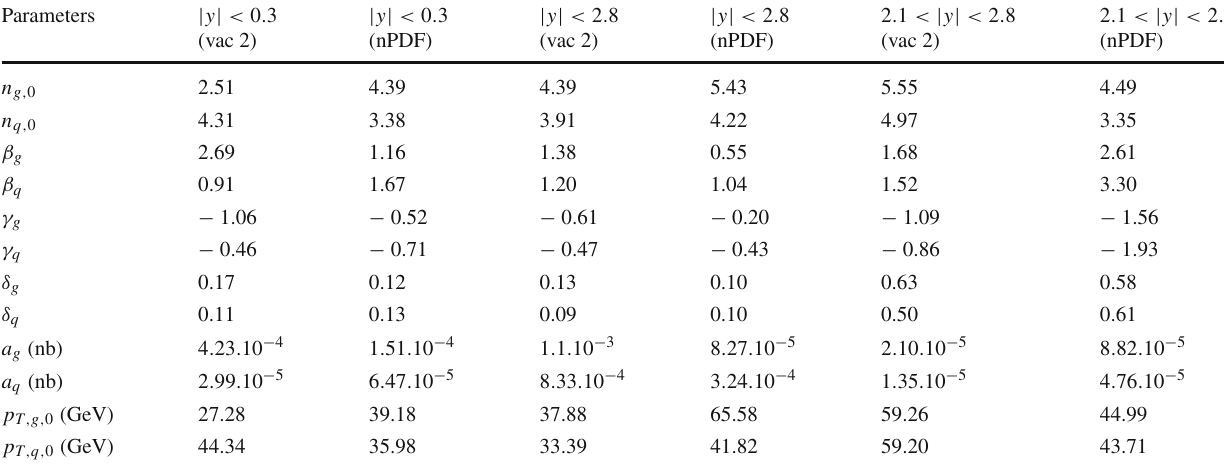
Table 1 List of parameters for the configurations “vacuum 2” and “nPDF”